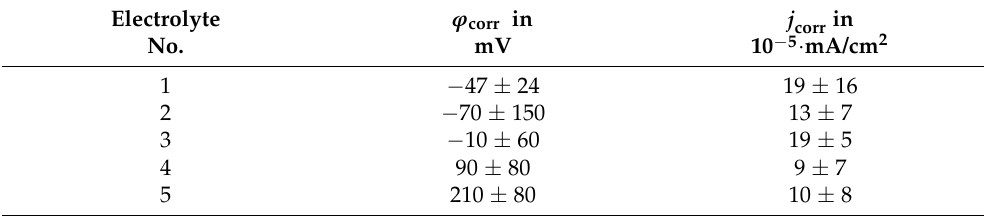
Table 2. Average values and standard deviations of ϕ corr and j corr (Equation (13)) in different electrolytes.